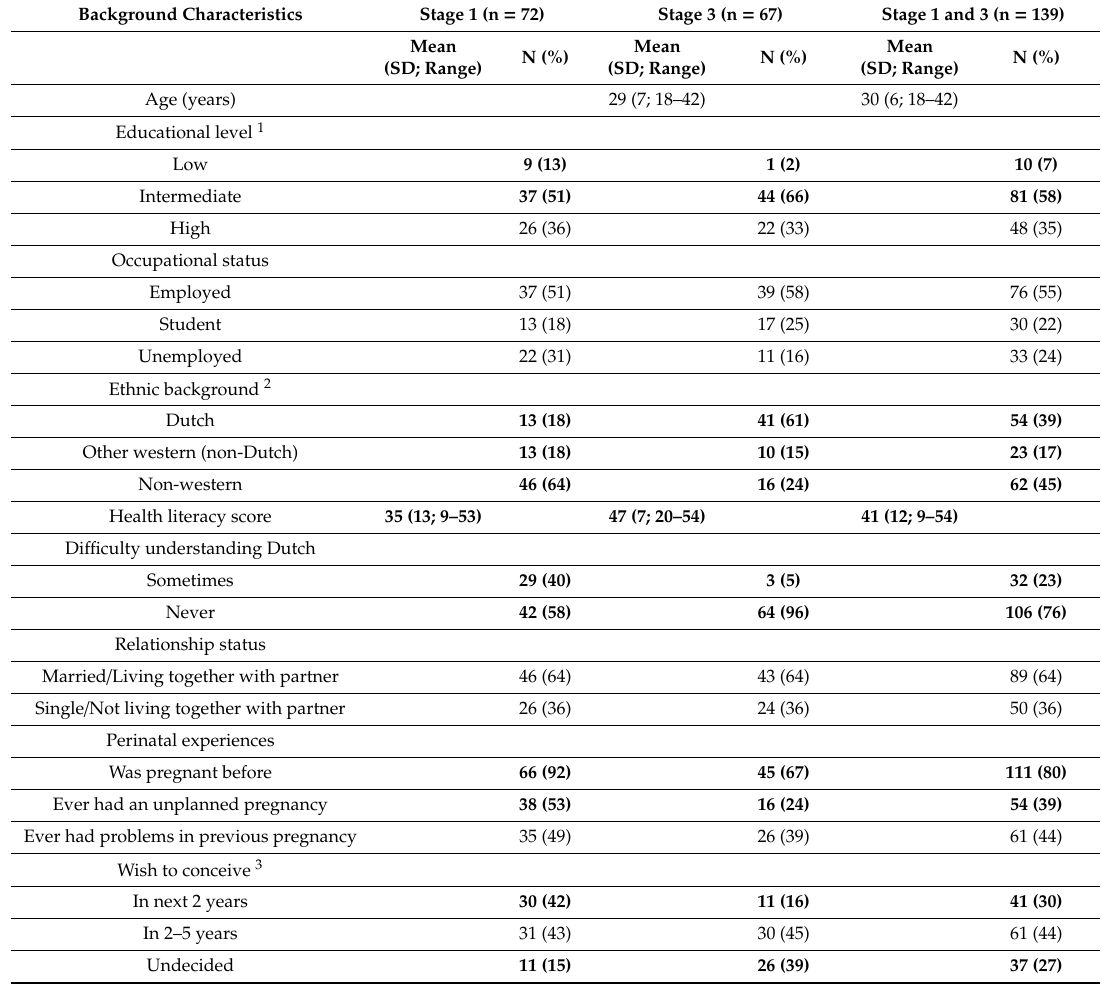
Table 3. Background characteristics stage 1 and 3 (n = 139).